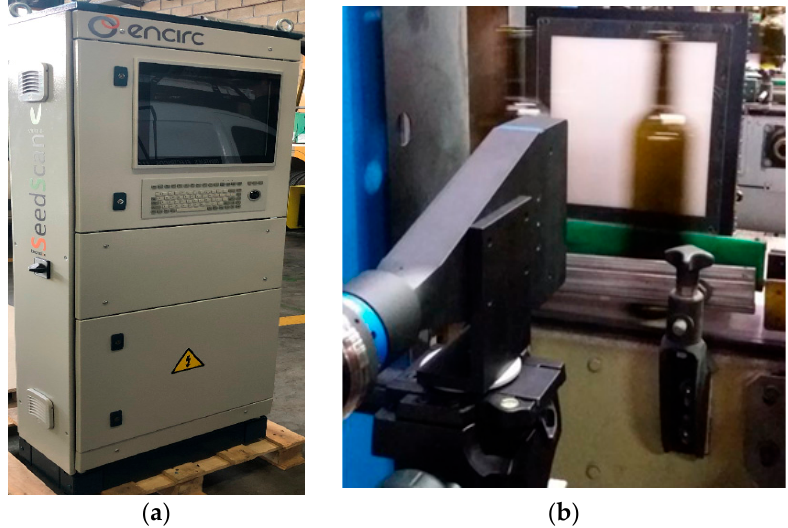
Figure 2. Images of the system: ( a ) cabinet of the system; ( b ) layout of the vision module. By means of an easy-to-use graphical interface, the user can start the process. The inspection process, once started, will automatically continue until stopped by the user.